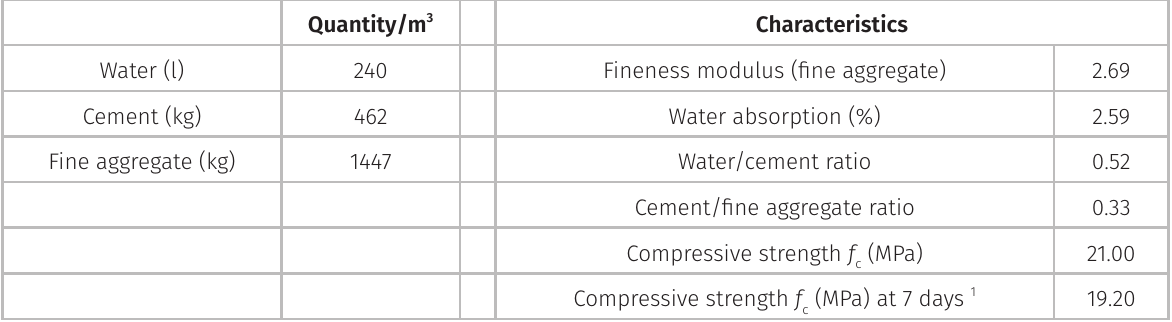
Table IV. The mixture proportions for the plain mortar, main aggregate characteristics, design’s specifi cation, and the amount of raw material needed to fabricate one cubic meter of mortar.